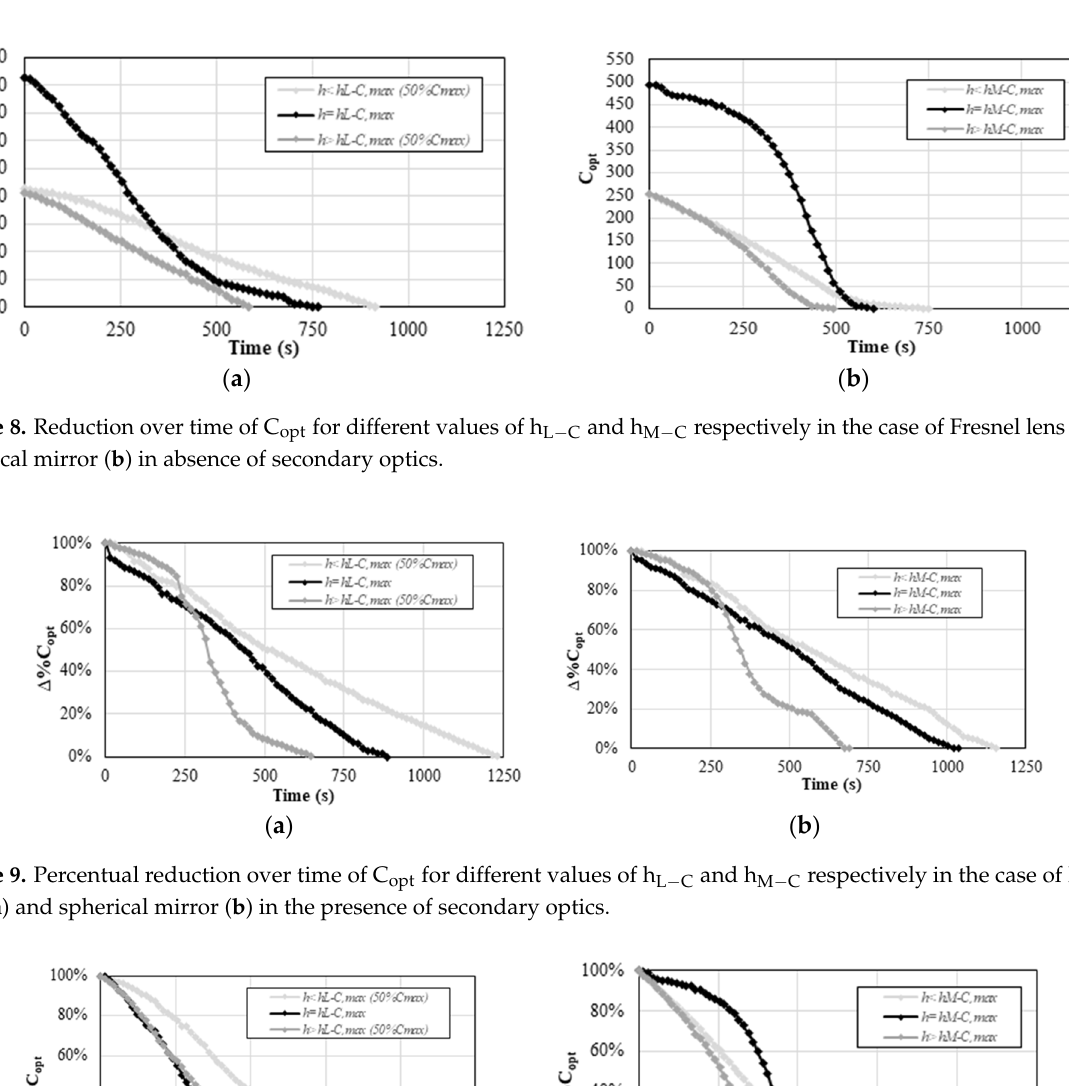
Figure 9. Percentual reduction over time of C (cid:2925)(cid:2926)(cid:2930) for different values of h (cid:2896)(cid:2879)(cid:2887) and h (cid:2897)(cid:2879)(cid:2887) respectively in the case of Fresnel lens ( a ) and spherical mirror ( b ) in the presence of secondary optics.